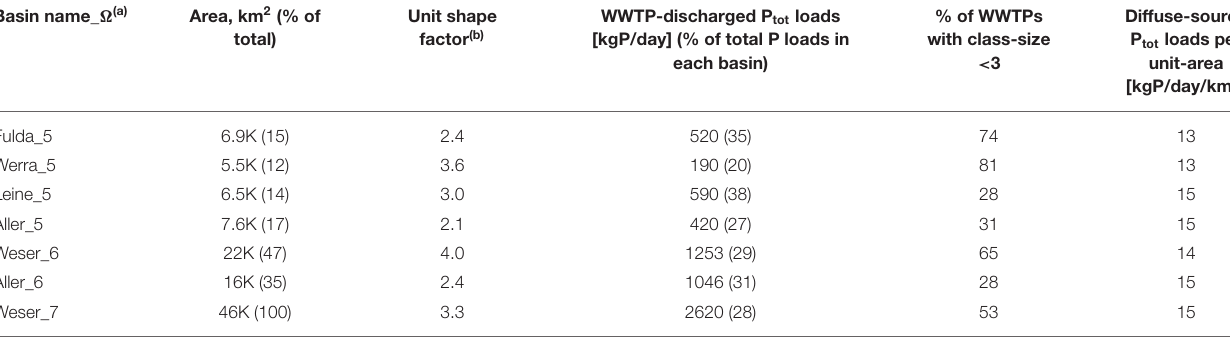
TABLE 1 | Information for the Weser River Basin and six